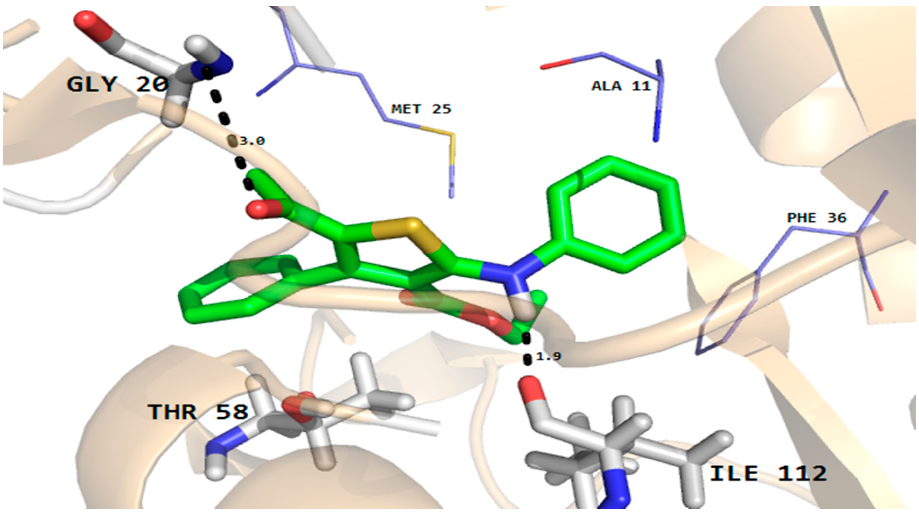
Figure 5. Molecular docking conformation of compound 5 in the active site of C. albicans dihydrofolate reductase protein (PDB ID 4HOF) showing hydrogen bonding, hydrophobic and van der Waals interactions.